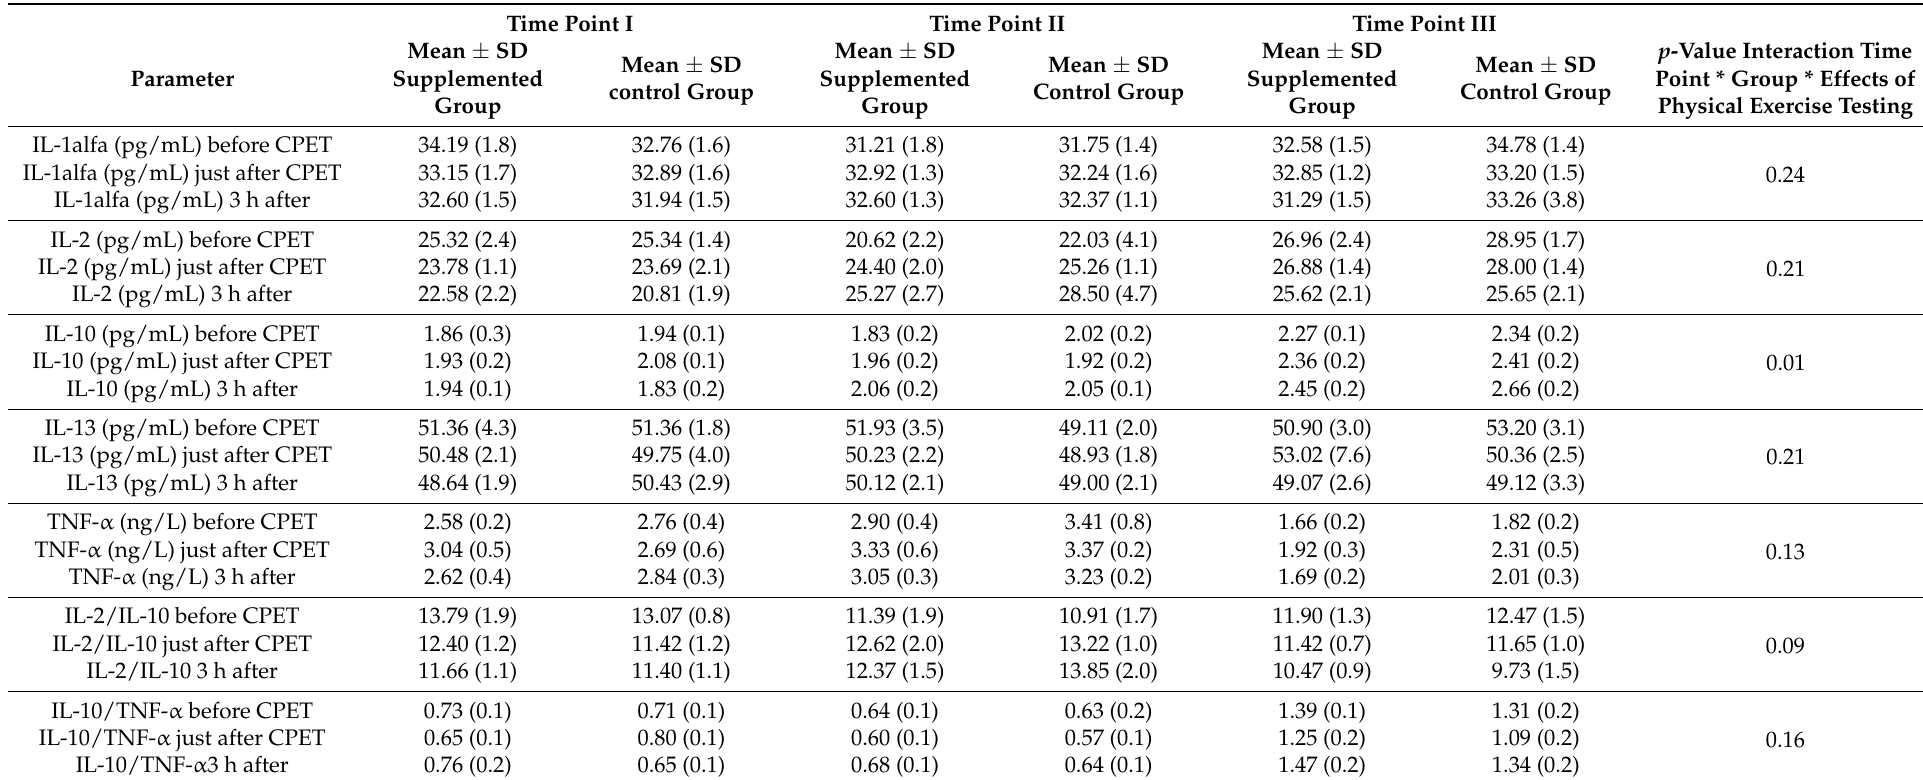
Table 3. Effects of supplementation on immune system function